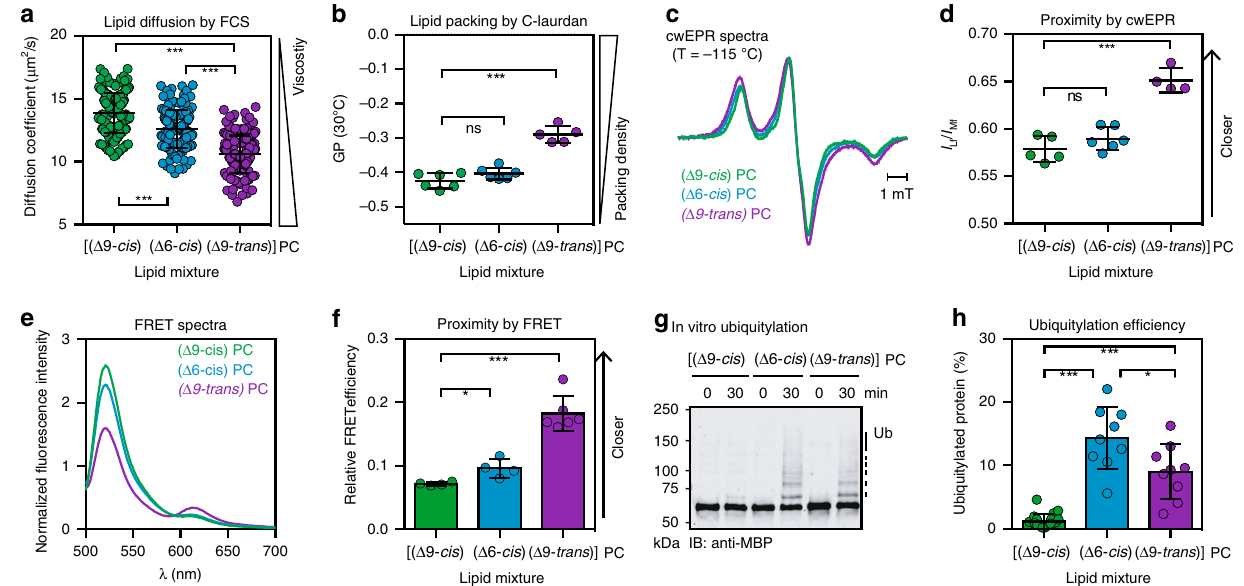
Fig. 5 The double bond in unsaturated lipid acyl chains affects the con fi guration and activity of the sense-and-response construct. a Diffusion coef fi cients of the fl uorescent lipid Atto488-DPPE in GUVs with indicated compositions were determined by confocal point FCS. Data for DOPC ( Δ 9- cis ) are the same as in Fig. 4a. Data are plotted as mean ± SD ( n ( Δ 9- cis ) = 172; n ( Δ 6- cis ) = 162; n ( Δ 9- trans ) = 163) and analyzed using Kolmogorov – Smirnov tests (*** p < 0.001). b Lipid packing in liposomes was determined by C-Laurdan spectroscopy. Data for DOPC ( Δ 9- cis ) are the same as in Fig. 4b. Data are plotted as mean ± SD ( n ( Δ 9- cis ) = 6, n ( Δ 6- cis ) = 6; n ( Δ 9- trans ) = 5) and analyzed via unpaired two-tailed, Student ’ s t -tests (*** p < 0.001). c Intensity- normalized cwEPR spectra recorded at − 115 °C for MBP Mga2 1032 – 1062 labeled at position W1042C after reconstitution at a molar protein:lipid ratio of 1:500 in liposomes with indicated composition. d Semi-quantitative proximity index I Lf / I Mf derived from cwEPR spectra. High values indicate low average interspin distances. Data are plotted as mean ± SD ( n ( Δ 9- cis ) = 5; n ( Δ 6- cis ) = 6; n ( Δ 9- trans ) = 4) and analyzed using two-tailed, unpaired t -tests (*** p < 0.001). e Fluorescence emission spectra of the membrane-reconstituted FRET pair (K983 D + K969 A ) (ex: 488 nm, em: 500 – 700 nm) are plotted after normalization to the maximal emission upon acceptor excitation (ex: 590 nm). Data for DOPC ( Δ 9- cis PC) are the same as in Fig. 3f. f Relative FRET ef fi ciencies were calculated as in e , plotted as mean ± SD ( n ( Δ 9- cis ) = 4; n ( Δ 6- cis ) = 4; n ( Δ 9- trans ) = 6), and analyzed by two-tailed, unpaired t -tests (* p < 0.05; ** p < 0.005). Data for DOPC ( Δ 9- cis PC) are the same as in Fig. 3g. g In vitro ubiquitylation of the zipped sense-and-response construct ( ZIP- MBP Mga2 950 – 1062 ) reconstituted in indicated liposomes at a molar protein-to-lipid ratio of 1:8000 and at 30 °C. After stopping the reaction, the samples were subjected to SDS-PAGE and analyzed by immunoblotting using anti-MBP antibodies. h Densiometric quanti fi cation of ubiquitylation at the indicated time points from immunoblots as in g ). Data are plotted as mean ± SD ( n ( Δ 9- cis ) = 20; n ( Δ 6- cis ) = 9; n ( Δ 9- trans ) = 9. Data for DOPC ( Δ 9- cis PC) are the same as in Fig. 4f. Source data are provided as a Source Data fi